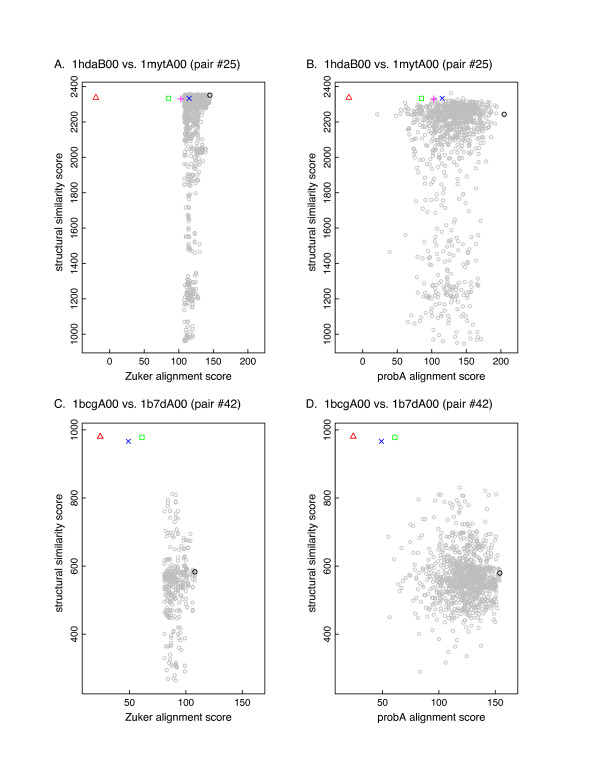
Structural and sequence similarity scores of near-optimal sequence alignments and structural alignments for the protein pairs shown in Figure 1. Figures A. and B., 1 hdaB00 vs 1 mytA00 (pair 25). Figures C. and D., 1bcgA00 vs. 1b7dA00 (pair 42). Figures A. and C. show Zuker-generated alignments within 95% of the optimal score, using the BLOSUM50 scoring matrix and gap open/extension penalties of -10/-2. Figures B. and D. show 1000 probA-generated alignments using the BLOSUM50 scoring matrix, and gap open/extension penalties of -9.5/-1.2. The X-axis shows the semi-global sequence alignment score; the Y-axis shows the corresponding Levitt-Gerstein structural similarity score. Optimal sequence alignment, black circle; suboptimal alignments, gray circles. Blue X, Dali; green square, CE; red triangle, LSQMAN; magenta +, Matras. The optimal sequence alignment in Figure 2A has a structural similarity score of 2352, higher than any of the structure-based alignment scores (RMSD 1.51 Å, shift score of 0.94 with respect to the DALI alignment). The structural alignments have structural similarity scores ranging from 2330 to 2337, with RMSDs of 1.47 Å. In Figure 2C, the optimal sequence alignment has a structural alignment score of 2167 (RMSD 1.33 Å, shift score with respect to DALI of 0.66). Structural alignments have structural alignment scores ranging from 2210 to 2274, with RMSDs from 1.35 - 1.38Å. Matras did not produce an alignment for 1bcgA00 vs. 1b7dA00.